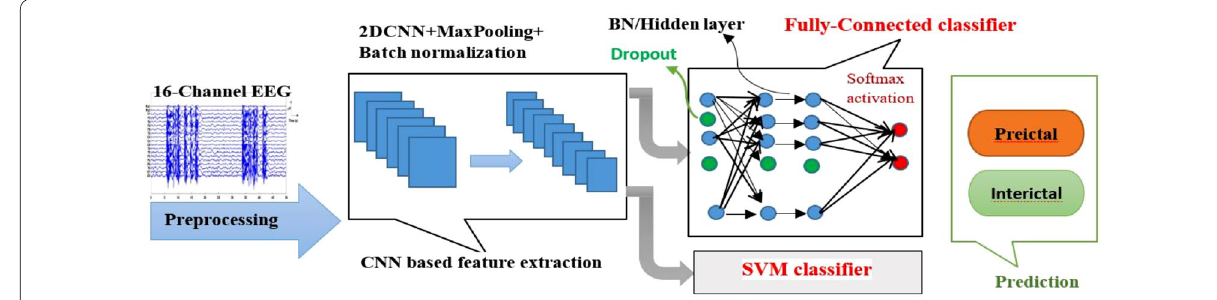
Fig. 2 Proposed generalizable